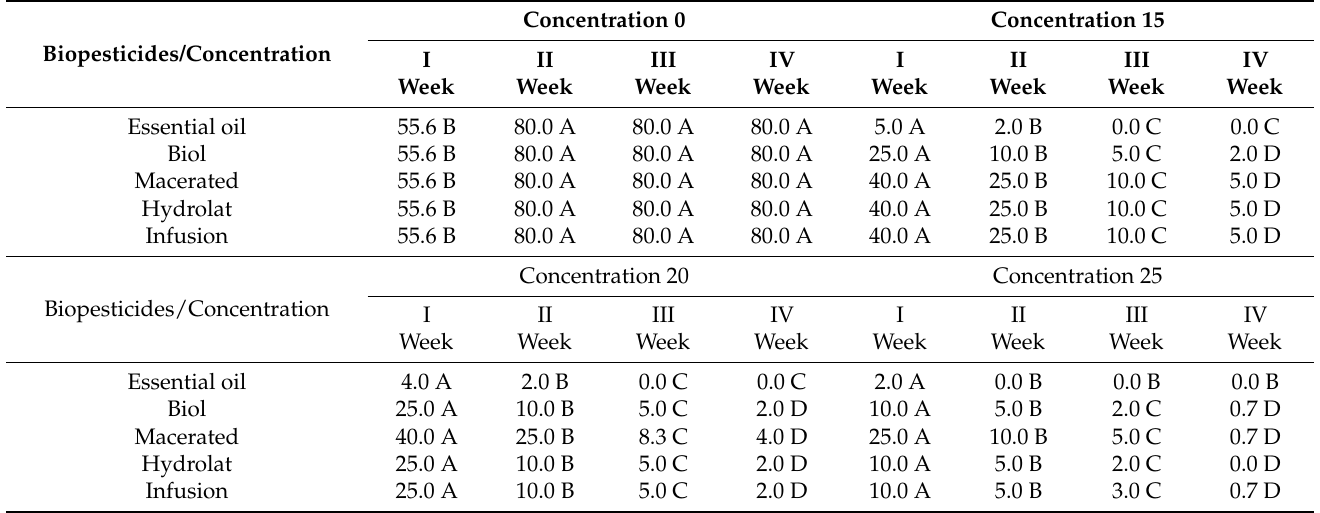
Table 5. Comparison of means in relation to the severity of five biopesticides in coffee for the control of rust, applied at four concentrations and evaluated on four different dates after field